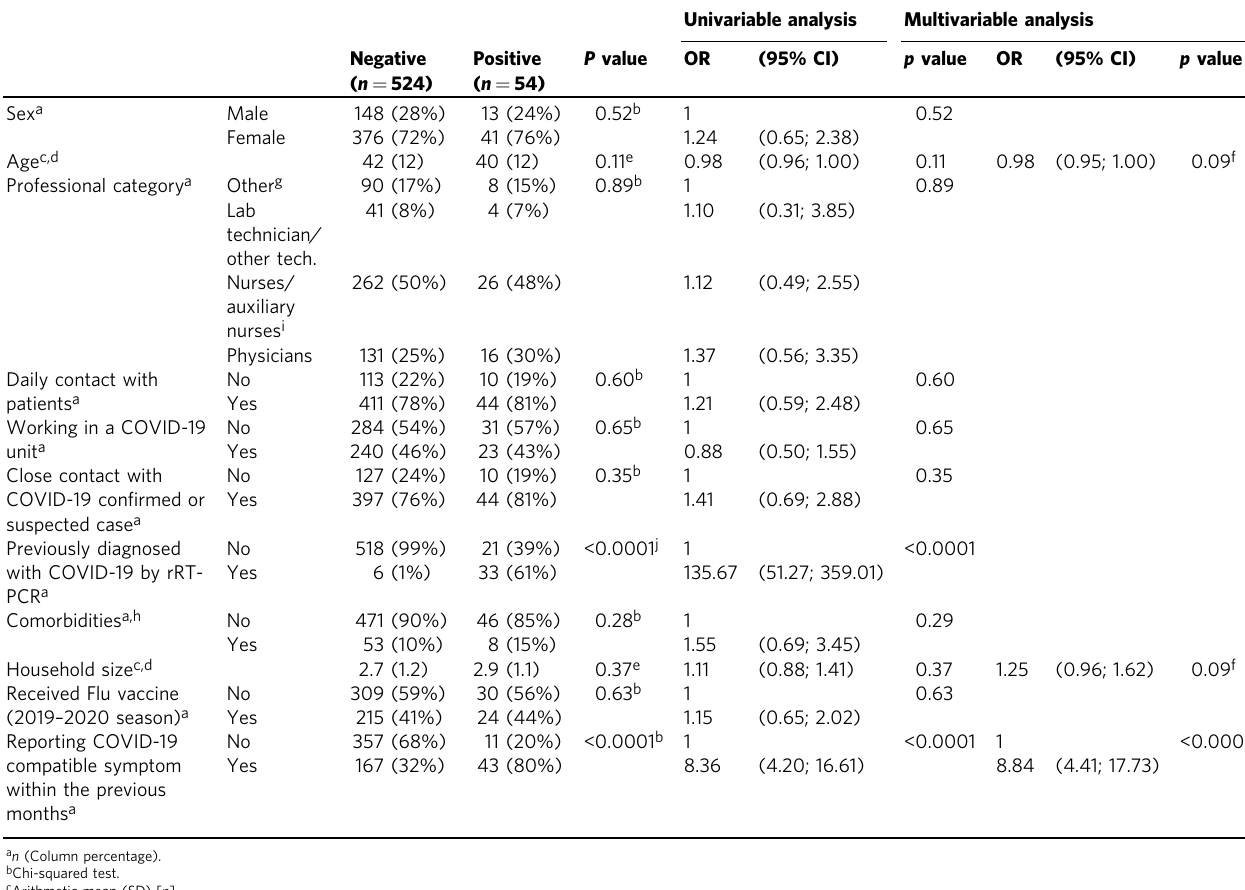
Table 3 Univariable and multivariable analysis of factors associated with having detectable antibodies (IgM and/or IgG and/ or